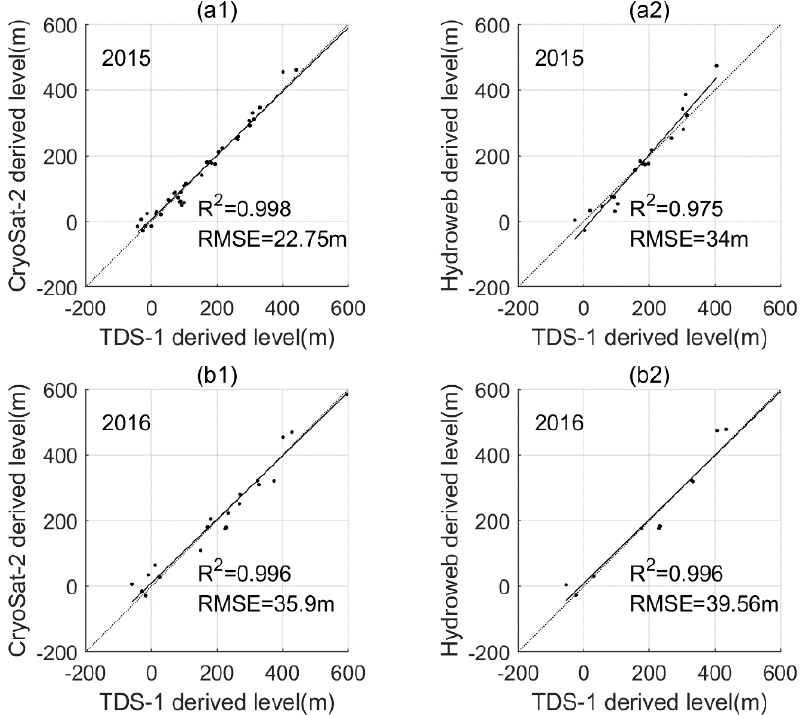
Figure 3. Correlations of TDS-derived lake level with that from CryoSat-2 and Hydroweb data during the summers of 2015 and 2016. ( a1 ) TDS-1 vs CryoSat-2 in 2015; ( a2 ) TDS-1 vs Hydroweb in 2015; ( b1 ) TDS-1 vs CryoSat-2 in 2016; ( b2 ) TDS-1 vs Hydroweb in 2016.